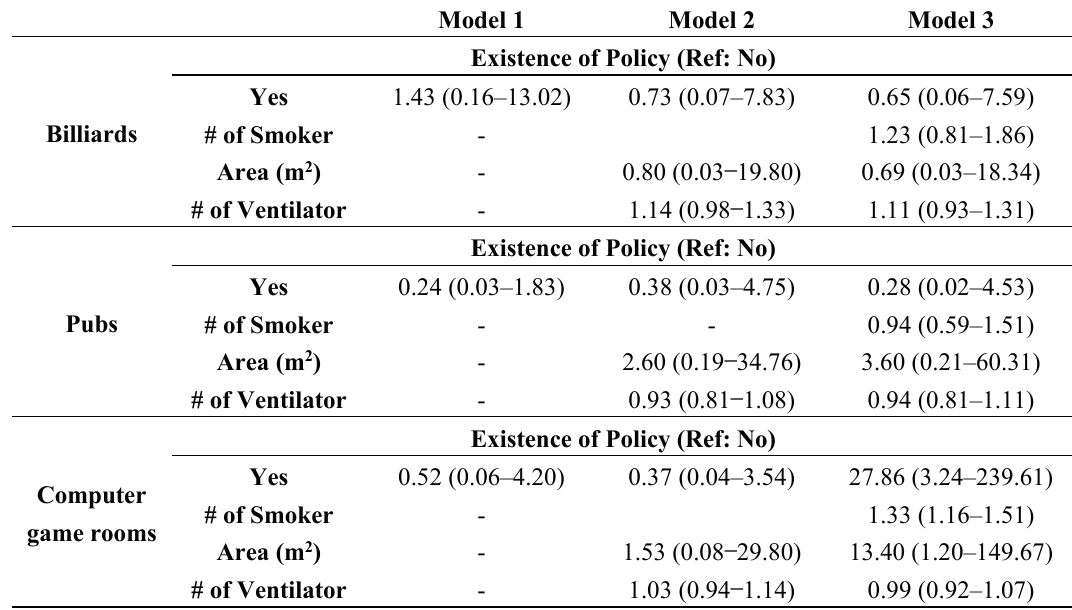
Table 3. Degree of change (95% CI) for indoor PM 2.5 concentration level by potential determinants selected over pre- or post-ban period (values are coefficients from the regression